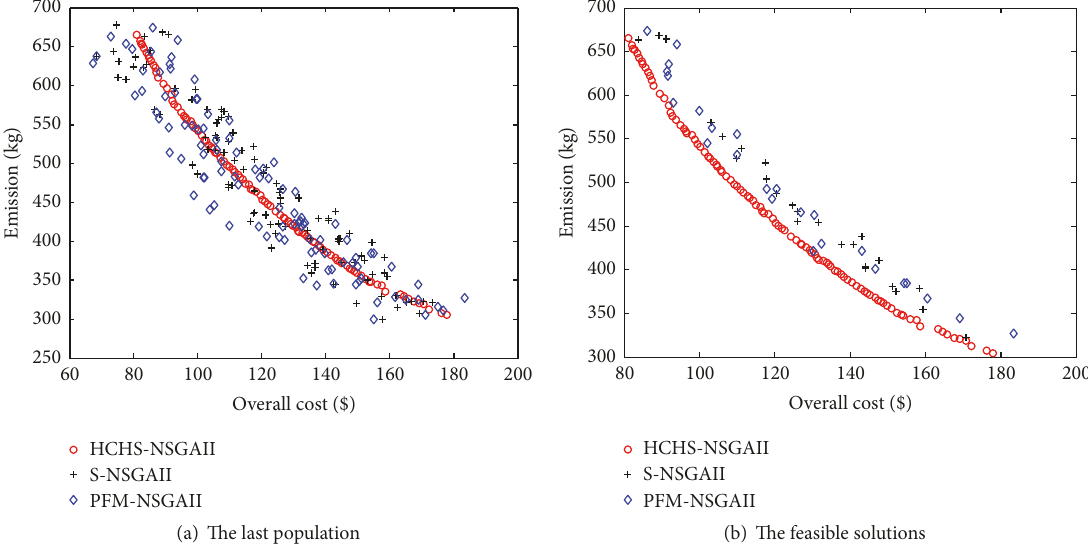
Figure 5: The best optimization results by HCHS-NSGAII, S-NSGAII, and PFM-NSGAII in Scenario